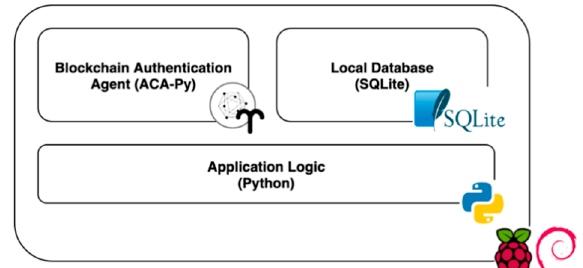
Figure 18. The Charging Station software infrastructure.